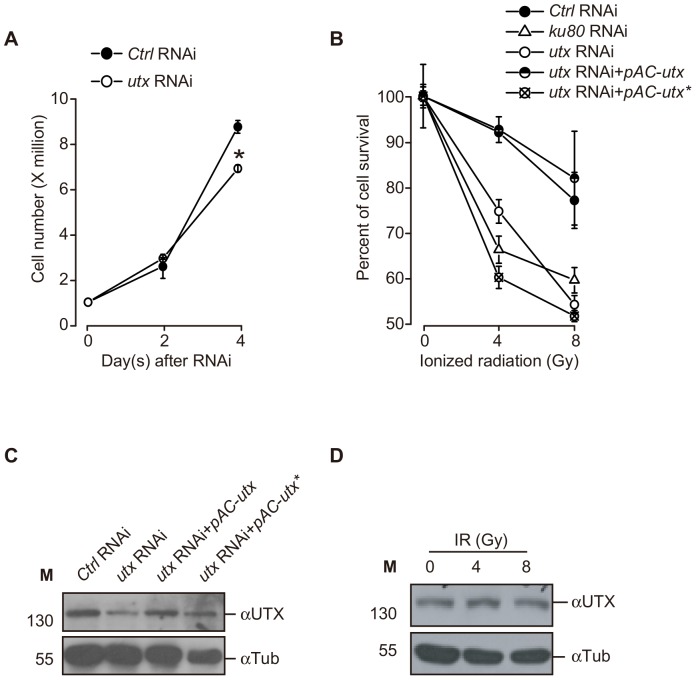
UTX is required for cell survival following IR exposure in Kc cells.(A) Cell counts at 2 and 4 days following RNAi treatment are indicated. Note that at 2 days, there is no difference in the growth rate of utx RNAi-treated compared to control (Ctrl) RNAi-treated cells. The asterisk indicates P<0.05 compared with the Ctrl RNAi group on the same day, as determined by two-way ANOVA followed by a post-hoc Tukey’s test for comparisons between groups. (B) utx RNAi-treated cells display significantly reduced cell counts compared to control RNAi-treated cells and over-expression wild type UTX could rescue RNAi effect but not mutant UTX after IR exposure. 4 days RNAi-treated cells were irradiated at doses of 4 and 8 Gy and examined relative cell viability after 2 days.(C) Western blot analysis of UTX expression confirming the efficiency of utx RNAi-mediated knockdown and over-expression of UTX. (D) IR treatment causes no detectable change in UTX protein levels. β-Tubulin (Tub) levels were used as loading controls. All of the data are representative of at least three independent experiments with similar results. Error bars indicate standard deviations from triplicate sets of the presented experiment.